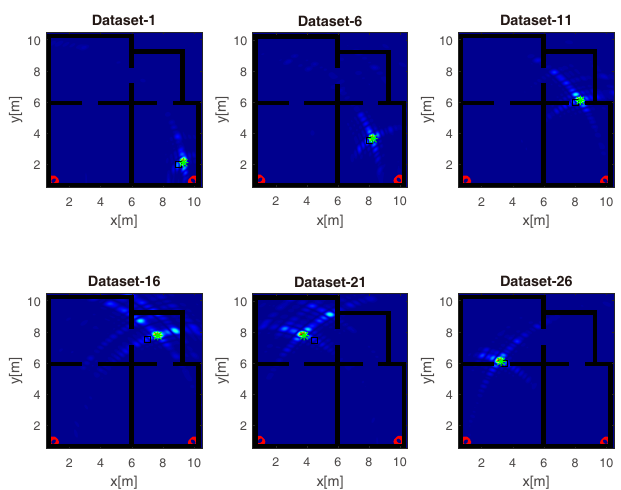
Figure 19. Tomographic images of a UWB source achieved with multiplicative array image fusion (E). Arrays (red circles); true source position (black square); estimated source position (green asterisk). Color scale is [0, 1].